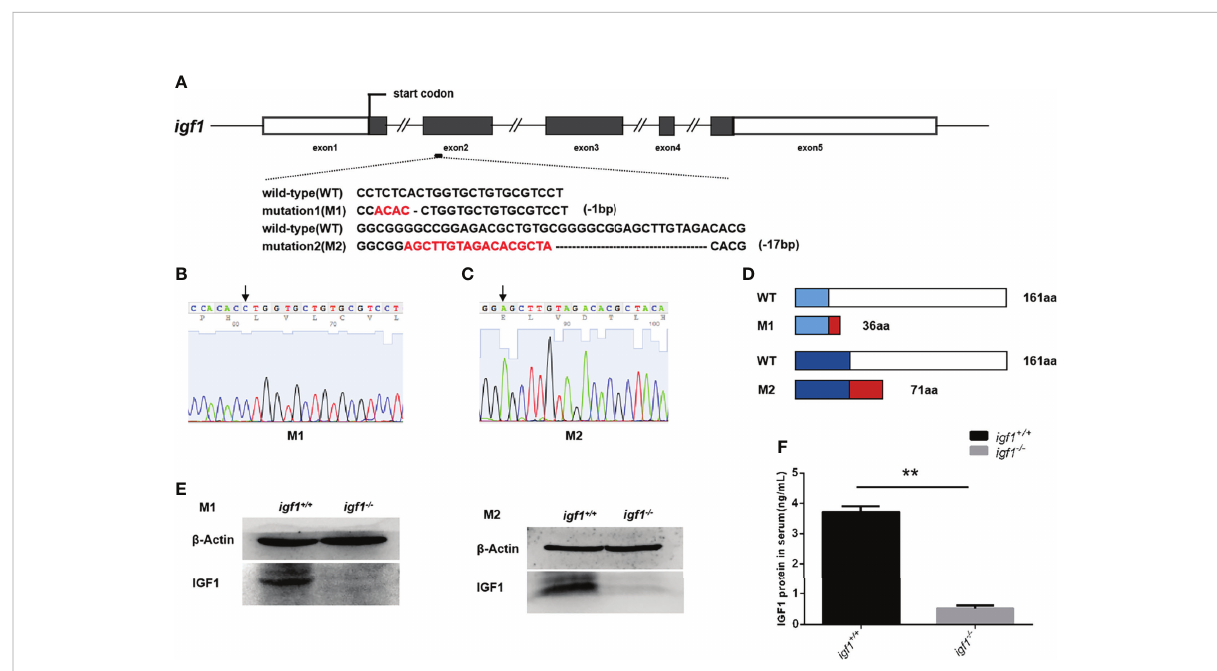
FIGURE 1 Generation of igf1- de fi cient zebra fi sh. (A) The diagram shows the endogenous structure of the zebra fi sh igf1 gene locus and selected targeting region. The dark boxes represent the coding regions the hollow boxes indicate non-translated regions, and the lines represent introns. The target site of CRISPR/Cas9 was located at exon 2. Two mutant lines were obtained at different target sites, namely mutant 1 (M1, -1bp) and mutant 2 (M2, -17bp). (B, C) Sequencing image of igf1 in M1 (B) and M2 (C) . The arrowhead indicates the upstream border of the deletions. (D) Diagram showing the putative peptides of the wild-type IGF1, M1, and M2 peptides. The mutant lines with putative peptides identical to those of WT fi sh are shown as blue areas, and the red areas indicate miscoded amino acids. (E) Western blotting of IGF1 protein in the hepatic organ of mutants and control siblings. Three biological repeats were carried out. (F) Circulating IGF1 levels of IGF1 were determined through ELISA. Four animals were sampled for each experiment and three biological repeats were carried out and statistical analysis was performed using a t test (P<0.01, n=3). ** P <